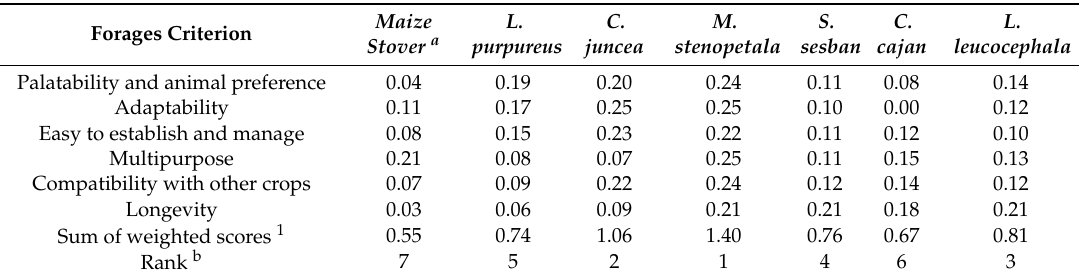
Table 6. Farmers’ preference and ranking of the